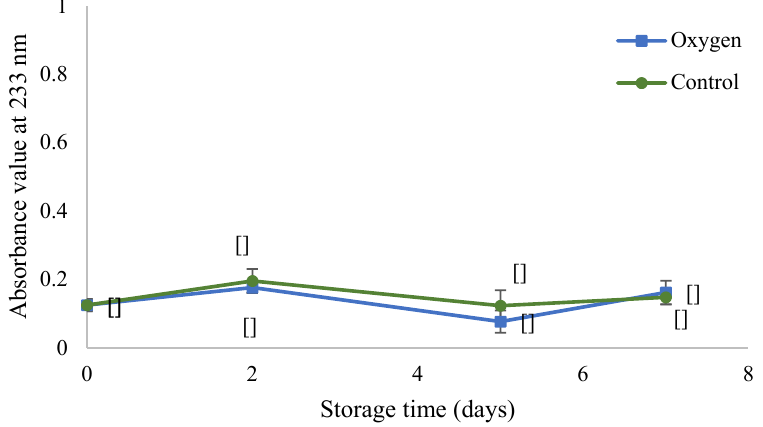
Figure 1. Variation in absorbance at 233 nm (conjugated diene (CD) values) of liquid infant milk formula stored under pure oxygen in the head space ( ■ oxygen) or under air ( ● ).